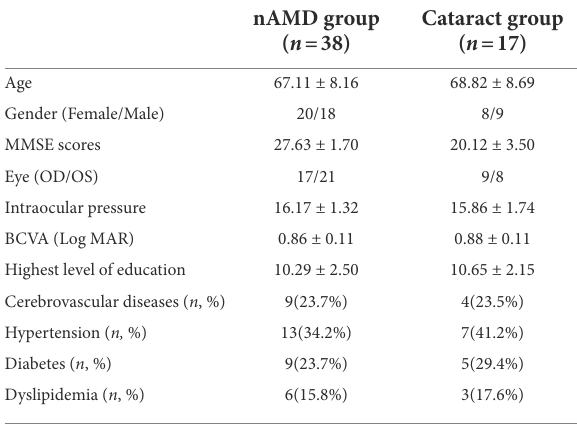
TABLE 2 General condition of the nAMD and cataract groups.